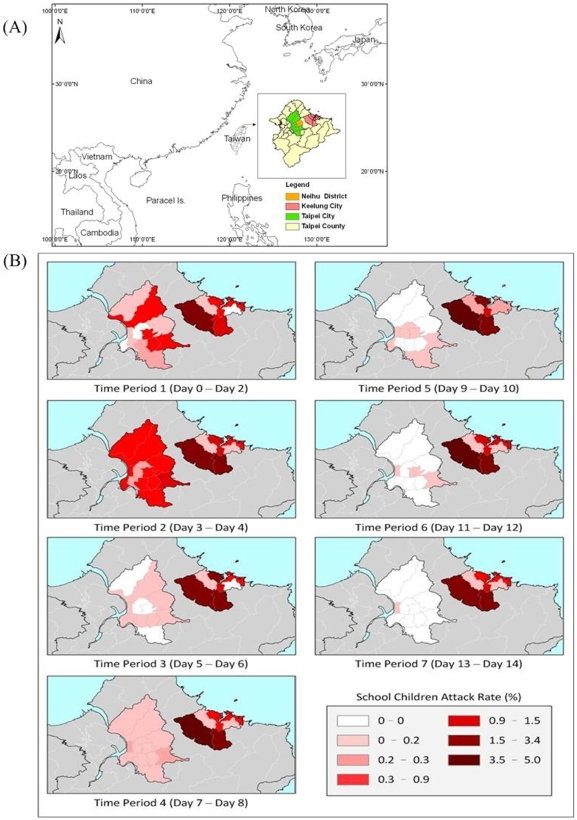
Spatial Distribution of the 2007 AHC Attack Rates in Taipei City and Keelung City.Geographical location of Taipei City and Keelung City and their spatial relationship was shown in panel A. Spatial and temporal changes of AHC attack rates (AR) between Taipei City and Keelung City were plotted according to their place in the outbreak timeline (panel B). Day 0 is used to indicate the days that cluster cases were first identified in Taipei or in Keelung cities. Darker colored areas indicate regions with higher AR.